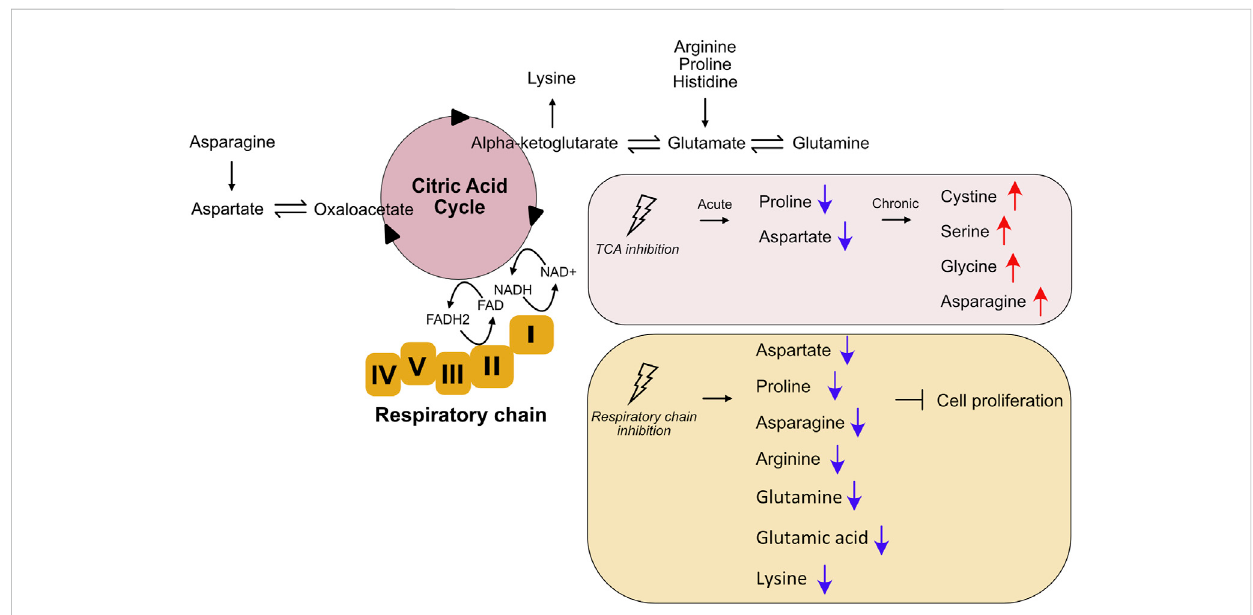
FIGURE 2 Changes of amino acid metabolism upon TCA cycle and respiratory chain inhibition. The TCA cycle is involved in both catabolism and anabolism of amino acids. The TCA cycle and the respiratory chain are closely linked both physically and functionally. Inhibition of TCA cycle and respiratory chain affect amino acid